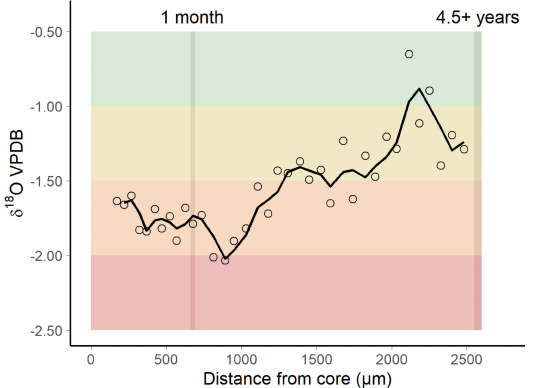
Figure 4. Measurements of δ 18 O values made by SIMS across the otolith growth axis from core to the near-edge in an adult yellowfin tuna. The 134 cm FL individual was captured in South Africa in May 2018. Dots are values measured at each spot, and solid line represents the mobile mean. The approximate location of the first month of life and 4.5+ years are indicated.